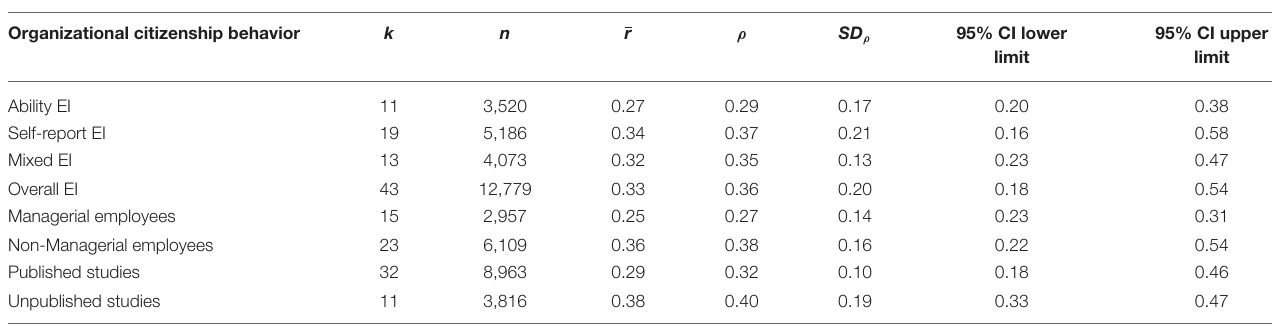
TABLE 4 | Meta-analytic results of the relationship between EI and